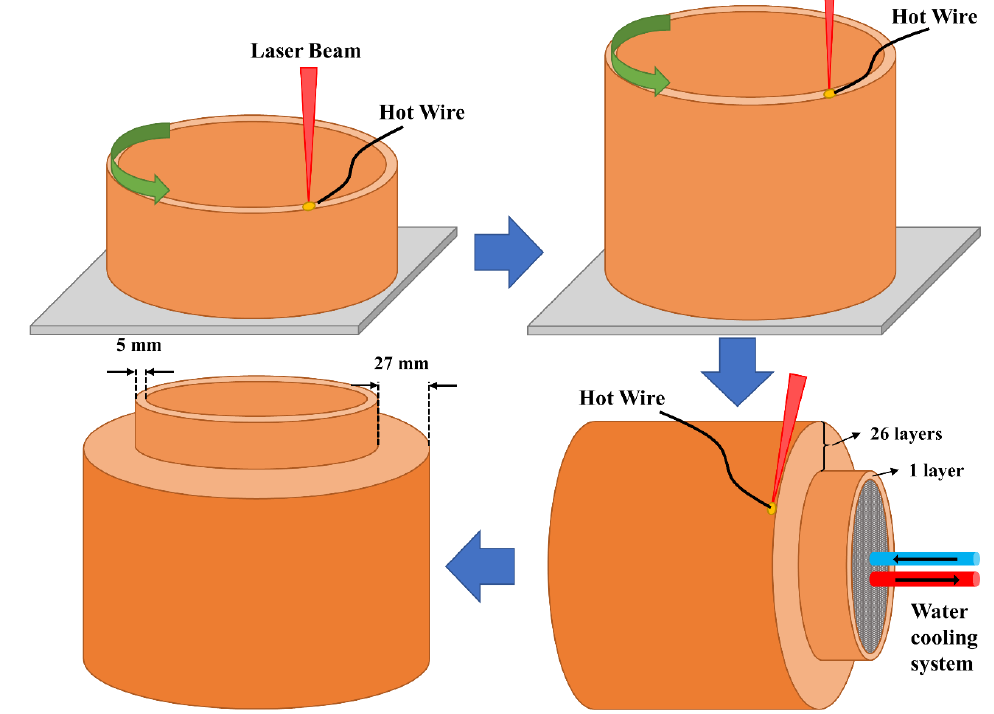
Figure 5. Steps in additive manufacturing of the cylinder. The circular deposition was used to build the inner section, which was used as the substrate for the LMDw of the second (outer) section. The first section also provided the possibility of using a water-cooling system. The deposition of the second section was perpendicular to the first deposition direction. Table 3. LMDw process parameters.